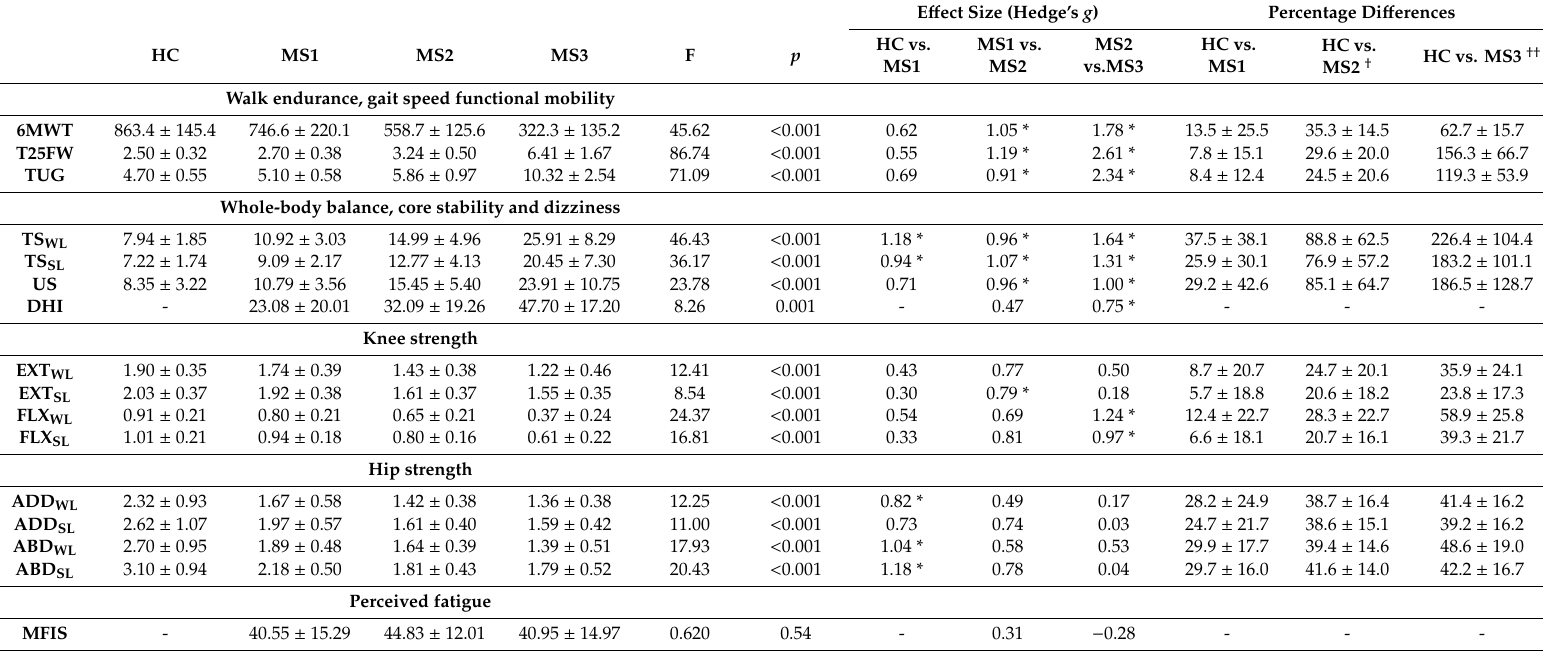
Table 2. Comparison of strength, balance, core stability and perceived fatigue parameters between healthy controls ( n = 22) and multiple sclerosis individuals with minimal ( n = 20), mild ( n = 23) and moderate impairment ( n =